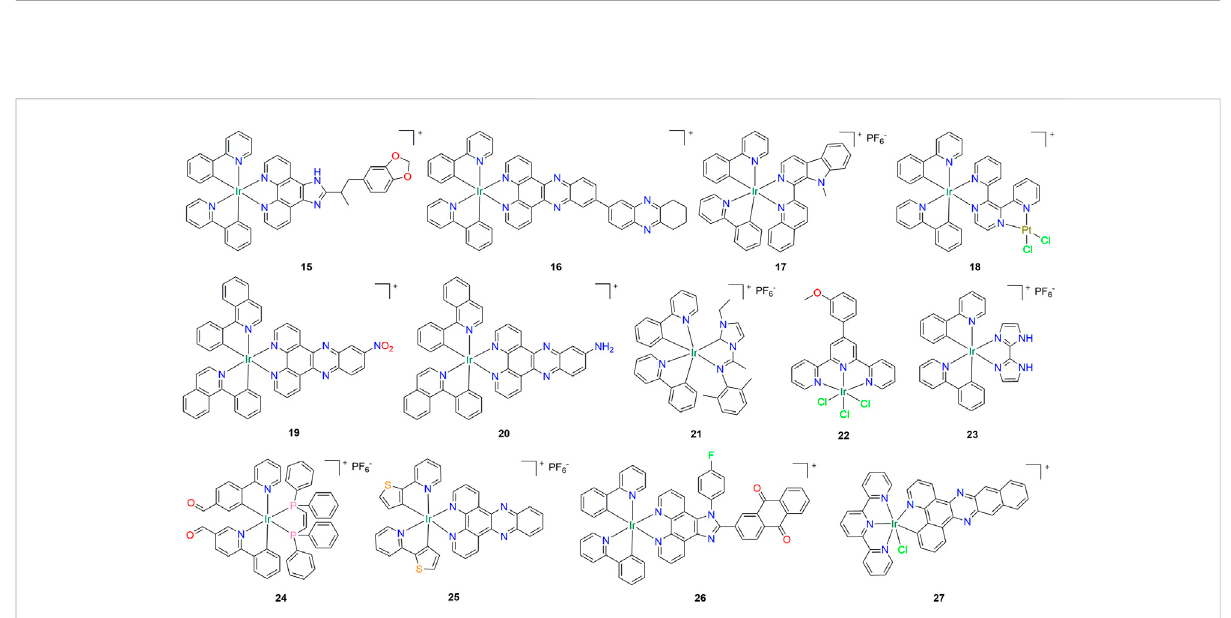
FIGURE 2 Structure of anti-lung cancer cyclometalated Iridium (III) compounds ( 15 – 27